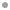
Blood Outgrowth Endothelial Cells (BOECs) from European adults and Ghanaian children.(A and B) Time (days) taken post-seeding for progenitor cells (□) and colonies (●) to appear and time to passage (day sub-culturing starts, △; ▲ denotes time to passage for donors who provided viable cells). BOECs were isolated from (A) European donors and (B) Ghanaian children. Patient data in B were grouped by blood volume: 2–5 mL (<5mL bottom panel) and 6–8 mL (>5ml top panel). (C) Appearance of progenitors and colonies and time to passage. Median days-post-seeding shown for each group; children (○), adult fresh samples (●) and adult frozen samples (●).